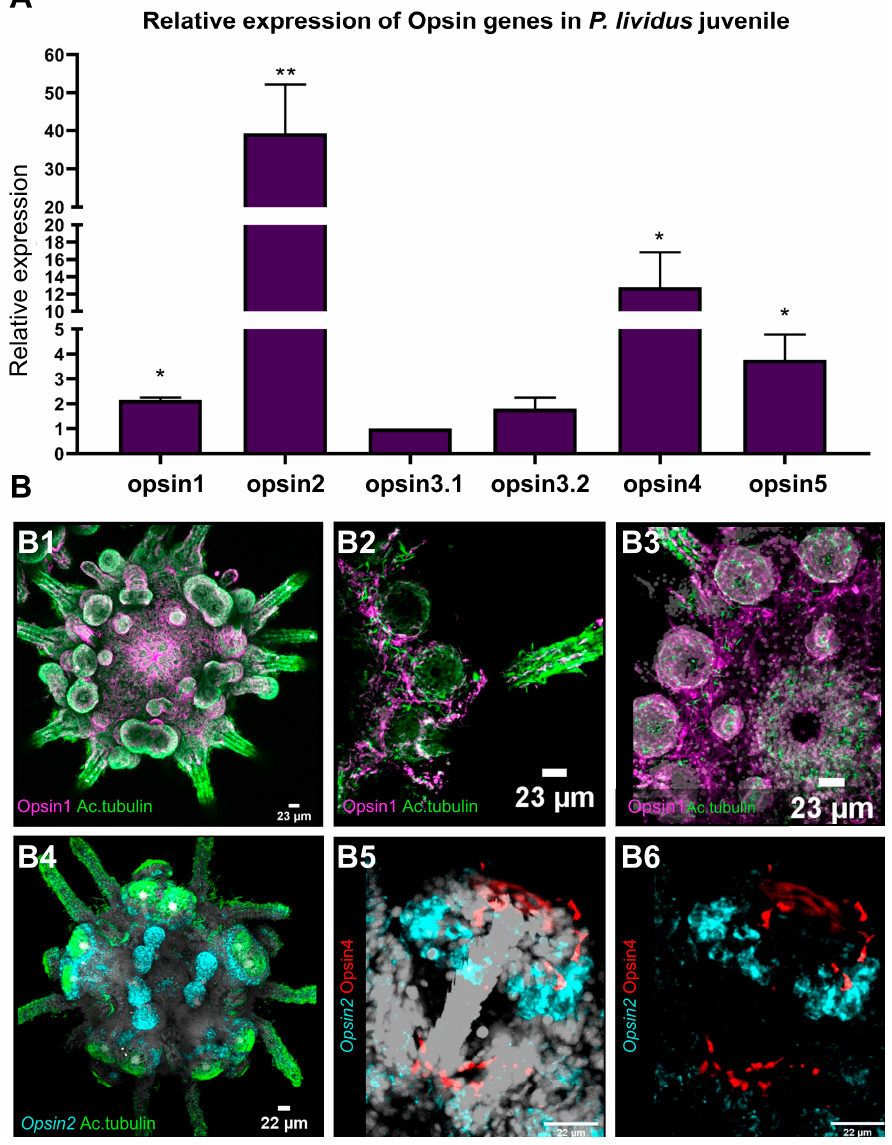
Figure 6. Expression analysis of Opsins in P. lividus juveniles. ( A ) Relative gene expression of different opsins in juveniles as revealed by qRT-PCR. Sample size: 3 biological replicates; Statistical significance cut-off criteria: * p < 0.05; ** p <0.01. ( B ) Gene expression visualization of Opsin1, opsin2 and Opsin4 at juvenile stage. ( B1 – B3 ) double IHC detection of Opsin1 (magenta) and acetylated tubulin labeling ciliated structures (green). ( B4 ) FISH using a specific antisense probe for Pl-opsin2 (cyan) paired with IHC for acetylated tubulin (green). ( B5 , B6 ) FISH for Pl-Opsin2 (cyan) transcripts paired with IHC detection of Opsin4 (red). DAPI was used to visualize nuclei (gray).